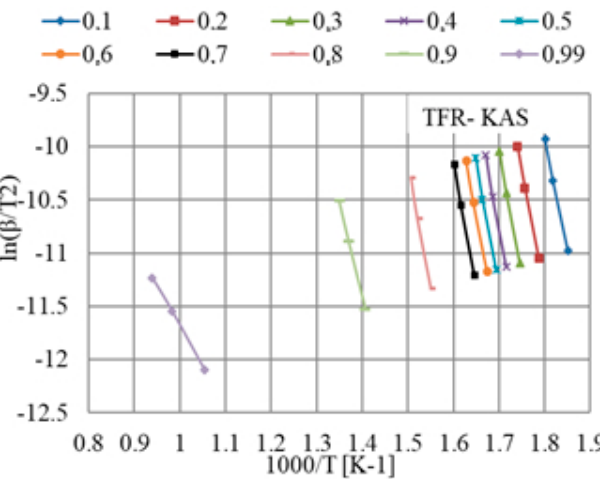
Figure 5. Plot deduced by applying the KAS model for the calculation of the activation energy for TFR at different heating rates.